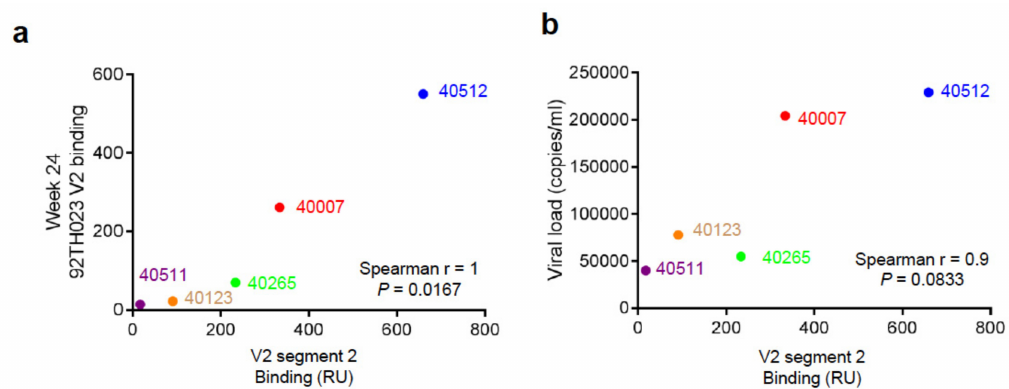
Figure 5. Statistical analysis of V2 binding, V2 segment 2 binding, and viral load titer. ( a ) Correlation of 92TH023 V2 plasma response with peak RV217 T / F V2 segment 2 binding response. ( b ) Correlation of RV217 participant viral load with RV217 T / F V2 segment 2 binding response at week 24. Spearman non-parametric correlation was performed assuming a two-tailed P